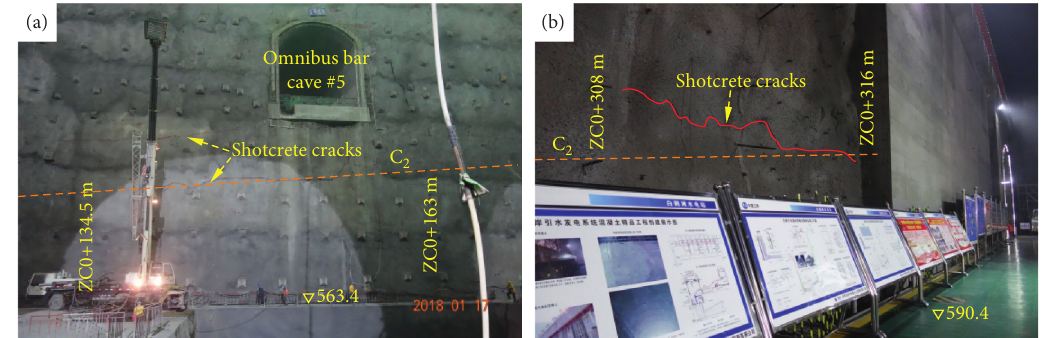
Figure 6: Shotcrete cracking of the main powerhouse downstream sidewall: (a) the section from stake ZC0 +134.5m to ZC0 +163m; (b) the section from stake ZC0 +308m to ZC0 +316 m.